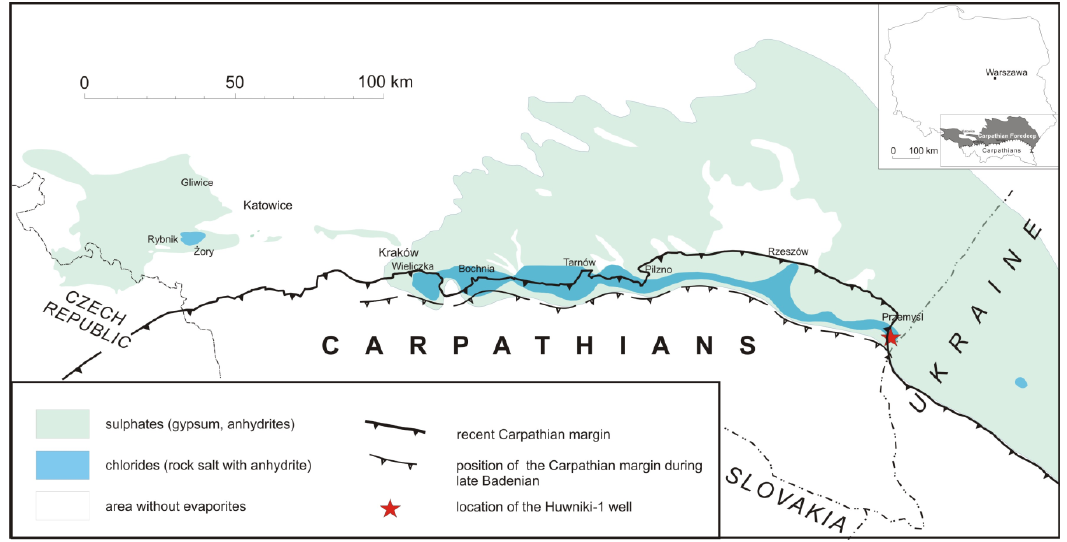
Figure 2. Distribution of the facies of the Badenian evaporites in the Carpathian Foredeep in Poland, after [28].